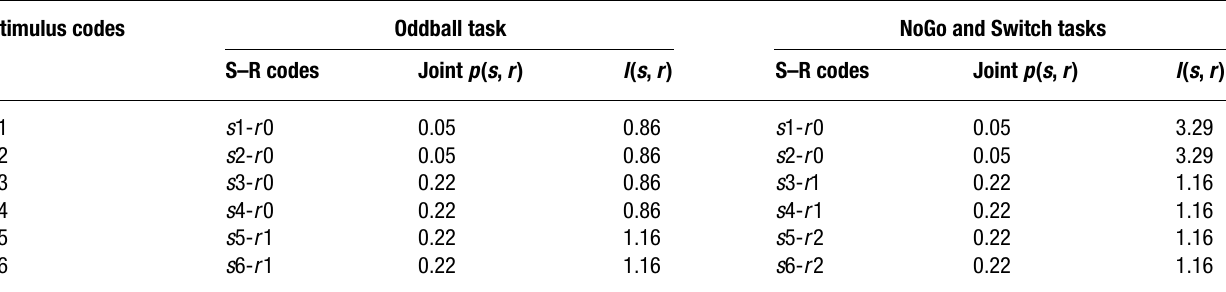
Table A3. Mutual information I s r . Only the S–R mappings for ‘shape’ classifi cations are illustrated here for